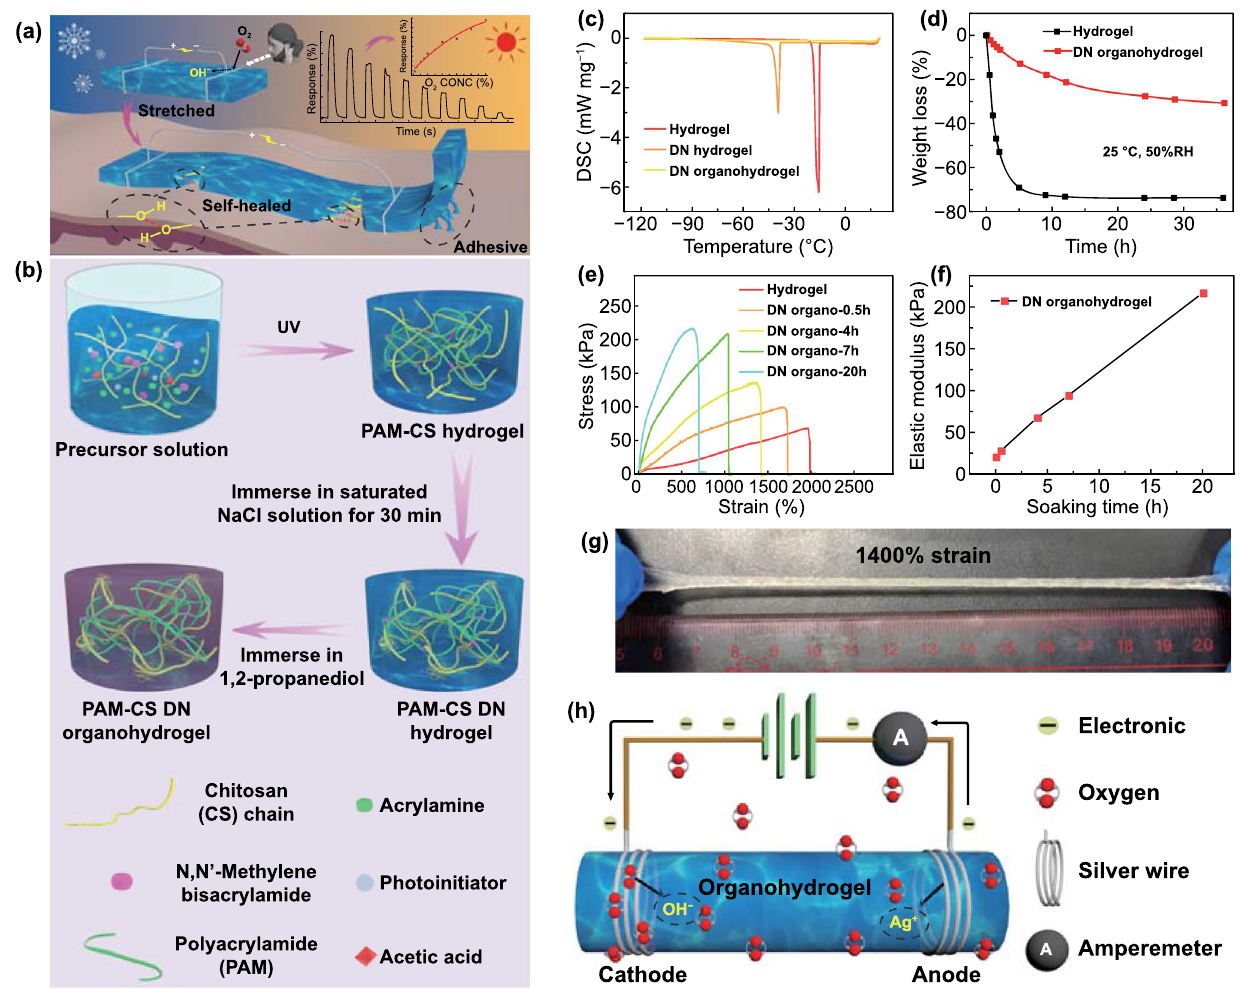
Fig. 1 a Schematic illustrating the organohydrogel-based stretchable, self-adhesive, self-healable oxygen sensors working at room temperature. b Scheme showing the synthesis of PAM-CS DN organohydrogel. c DSC curves of hydrogel, DN hydrogel, and DN organohydrogel. d Time evolution of the weight loss percentage of hydrogel and DN organohydrogel when stored at 25 ℃ and 50% RH. e Stress-strain curves of hydrogel and DN organohydrogels obtained by soaking in 1,2-PD for 0.5, 4, 7, and 20 h, respectively. f Plot of the elastic modulus of DN organohydrogel vs soaking time. g Photograph showing the DN organohydrogel at 1400% tensile strain. h Schematic illustrating the working principle of the oxygen